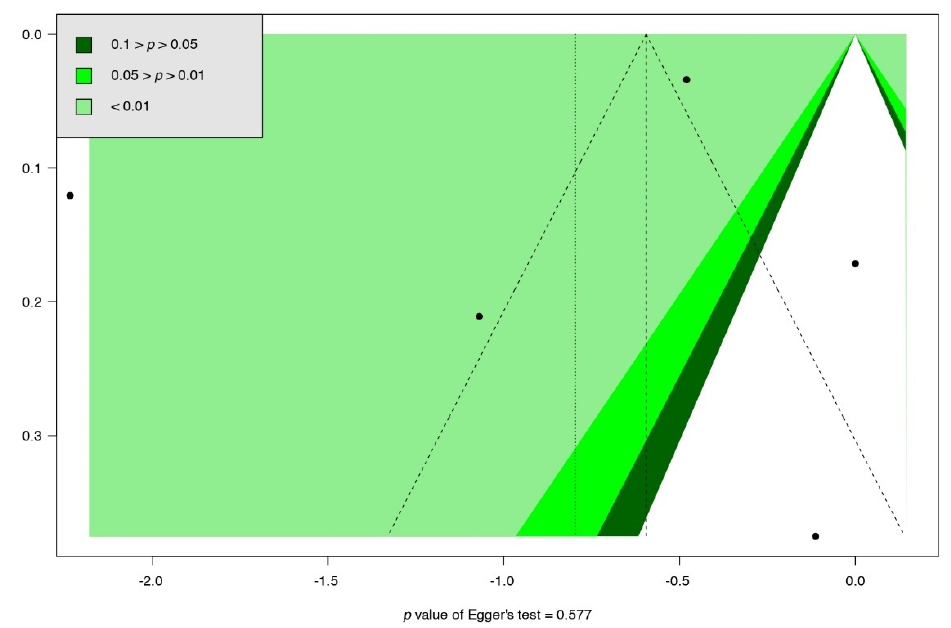
Figure A42. Comparison-adjusted funnel plot in outcome for hemoglobin drop.